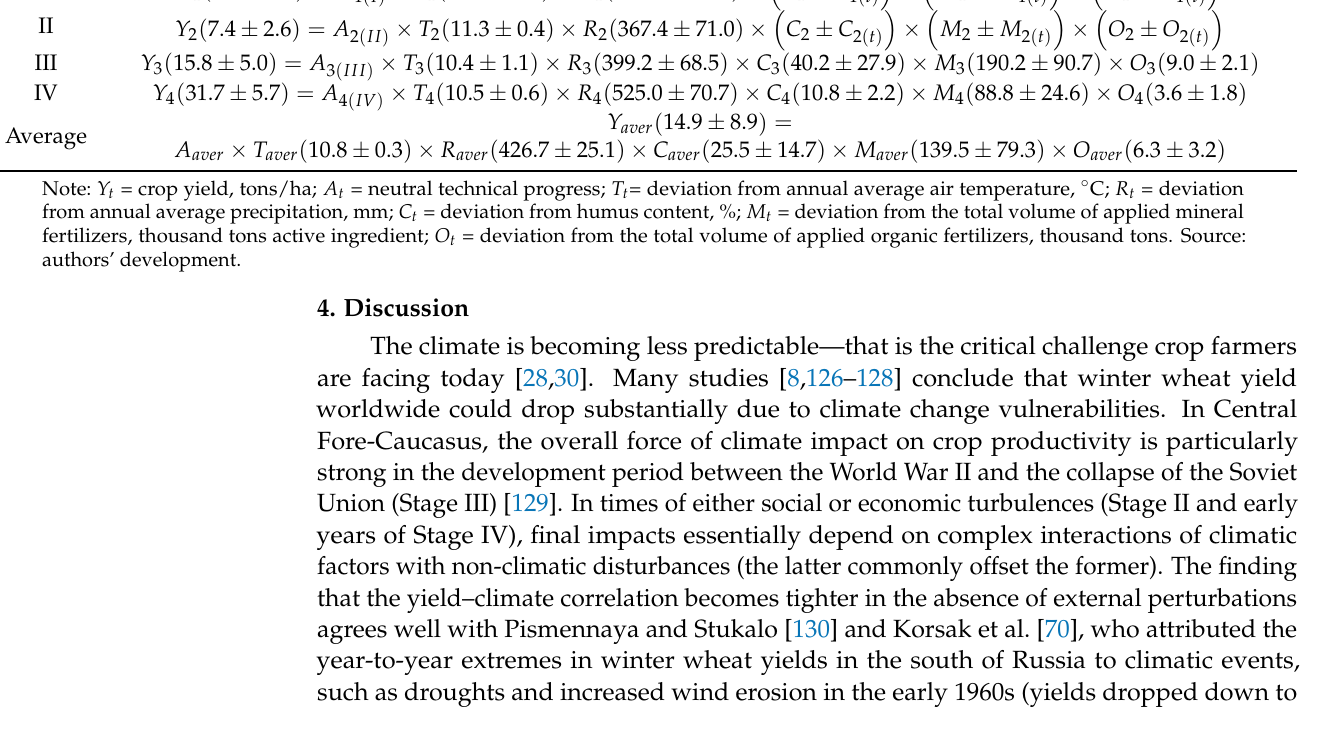
Table 5. Multiplicative climate–yield equations for winter wheat in Central Fore-Caucasus in 1850–2020. Stage